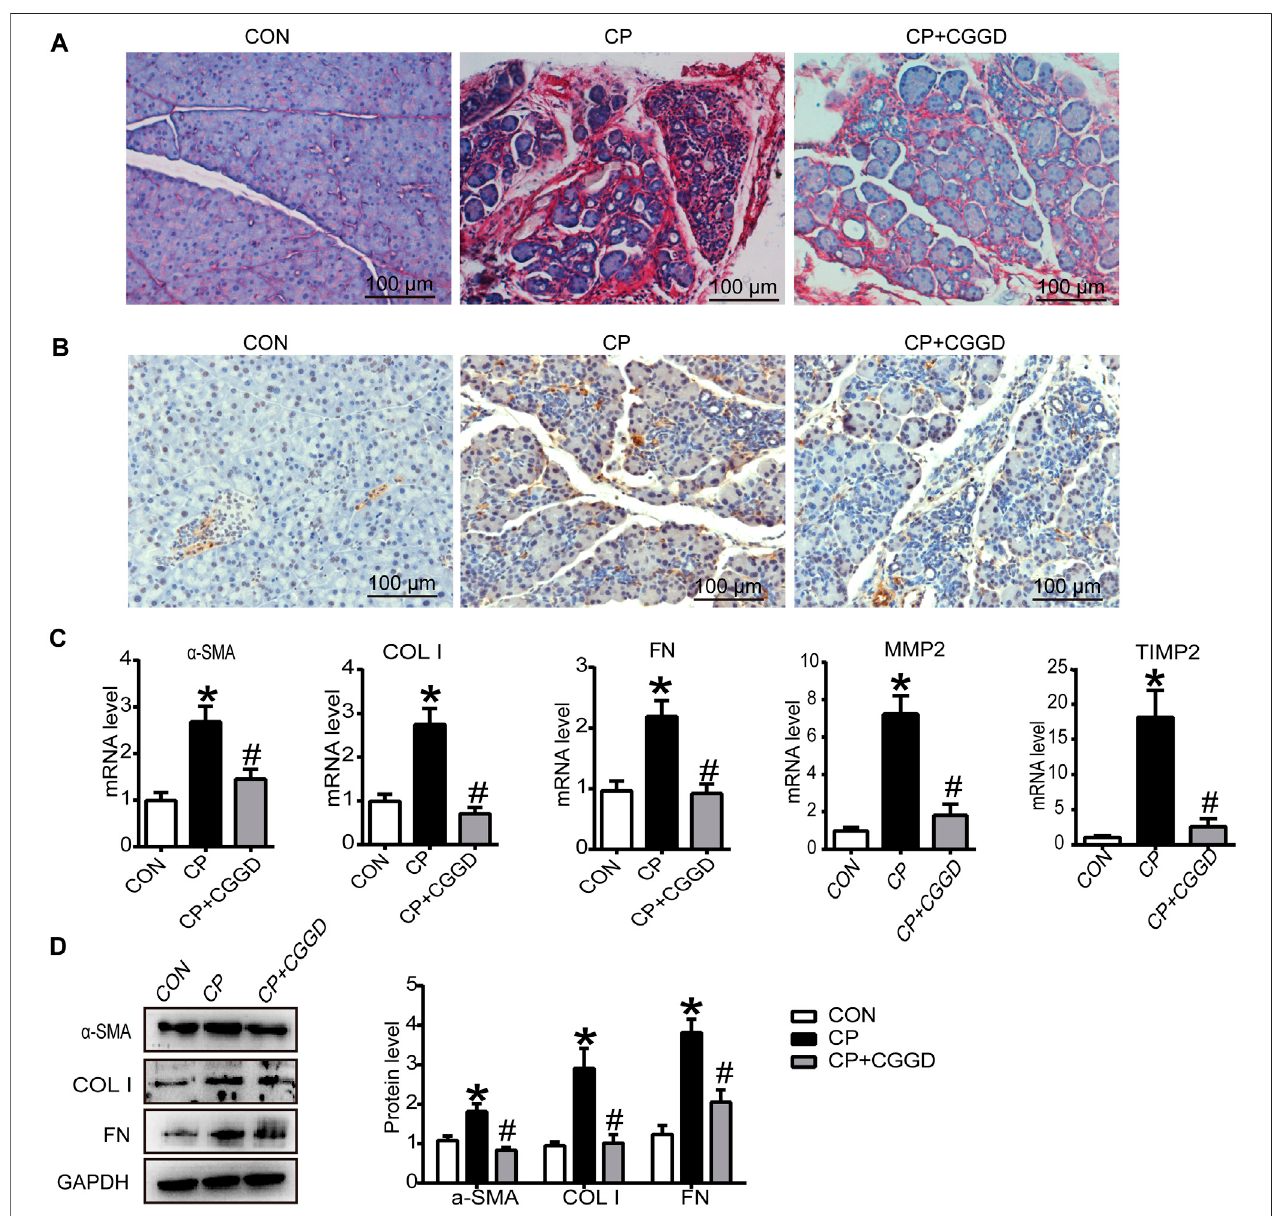
FIGURE 3 | Effects of CGGD on collagen deposition and PSC activation in the pancreas. (A) Sirius red staining for collagen deposition in the pancreas (original magni fi cation, × 200). (B) Immunohistochemistry staining of α -SMA (brown staining) in pancreatic tissues. Hematoxylin was used to counterstain nuclei (original magni fi cation, × 200). (C) qRT-PCRanalysisof α -SMA,COLI,FN,MMP2,andTIMP2. (D) Westernblotanalysisof α -SMA,COLI,andFN.Dataareexpressedasmean ± SD (n (cid:2) 3). * p < 0.05 compared with the control group; # p < 0.05 compared with the CP